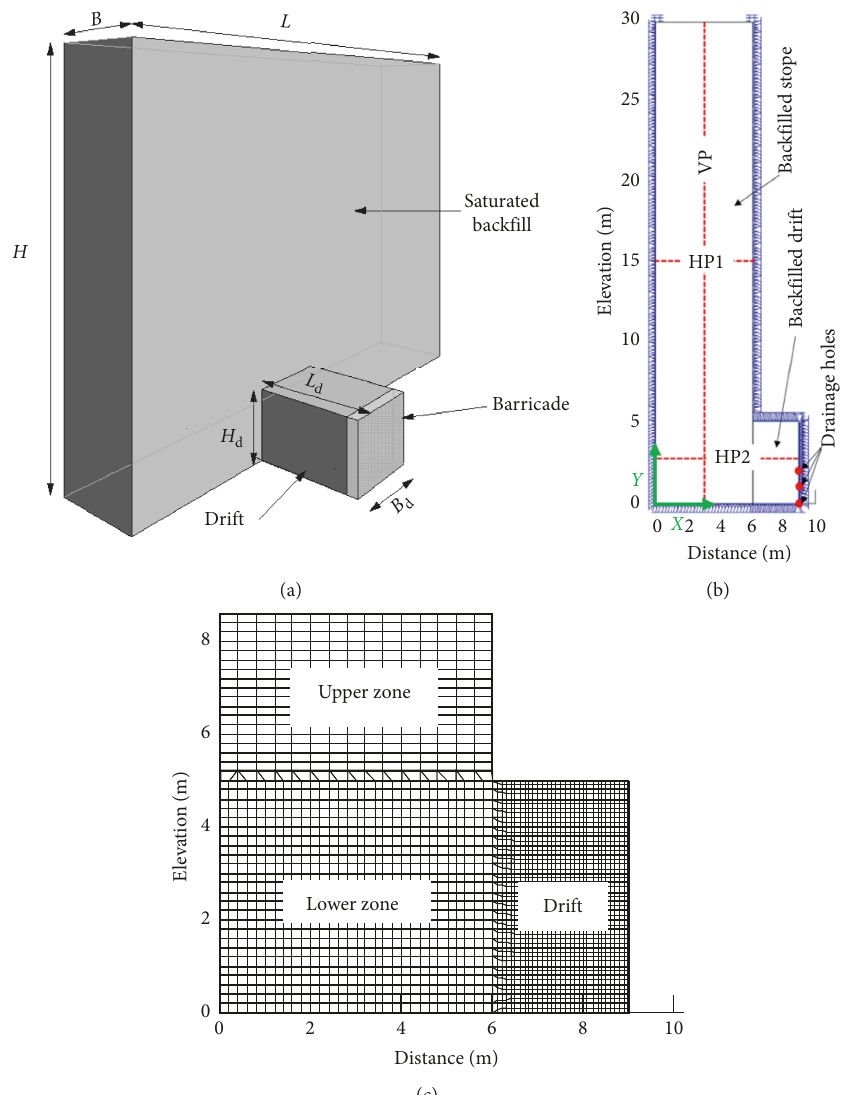
Figure 1: (a) A typical vertical backfilled stope with a drift and a barricade; (b) numerical model of the backfilled stope; (c) mesh zones near the base of the